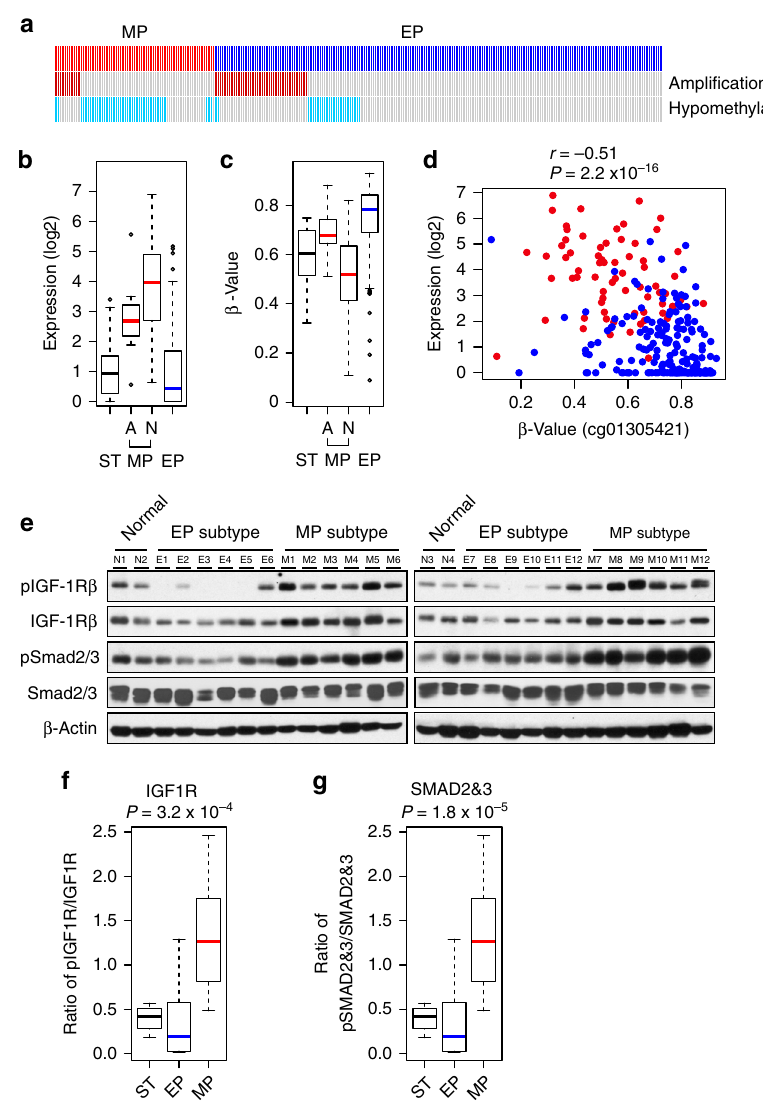
Fig. 7 Activation of IGF1/IGF1R pathway in the mesenchymal phenotype (MP) subtype of gastric cancer. a Copy number ampli fi cation and hypomethylation status of the IGF1 gene in MP subtype tumor samples ( n = 70) from The Cancer Genome Atlas (TCGA) cohort. Hypomethylation of the promoter region was determined by comparison with methylation of surrounding normal tissues (<0.6). EP epithelial phenotype. b Expression of IGF1 in MP subtype tumors, strati fi ed by IGF1 gene ampli fi cation in the cancer genome. A: ampli fi cation of IGF1, N: normal copy number, ST: surrounding tissue. Differences between ST and MP groups were signi fi cant ( P < 0.05 by Student ’ s t -test). Colored lines indicate the median, boxes extend from the 25th to the 75th percentile, and dashed error bars extend to the 10th and 90th percentiles. c Promoter methylation of the IGF1 gene (probe ID, cg01305421) in each subtype of gastric cancer and ST in the TCGA tumor samples. Colored lines indicate the median, boxes extend from the 25th to the 75th percentile, and dashed error bars extend to the 10th and 90th percentiles. Differences between ST and MP groups were signi fi cant ( P < 0.05 by Student ’ s t -test). d Correlation between mRNA expression and promoter methylation ( β -value), estimated using Pearson's correlation. e Western blot analysis for IGF1R, phospho-IGF1R, SMAD1/ 2, and phospho-SMAD2/3. Activation of IGF1R and SMAD2/3 was determined by western blot with phosphorylation-speci fi c antibodies as indicated. β - Actin was used as loading control. f , g Activation of IGF1R and SMAD2/3 in gastric cancer and normal gastric tissues is estimated by ratios of phosphorylated form over all proteins. P values for mutation rates were obtained using Student ’ s t -test